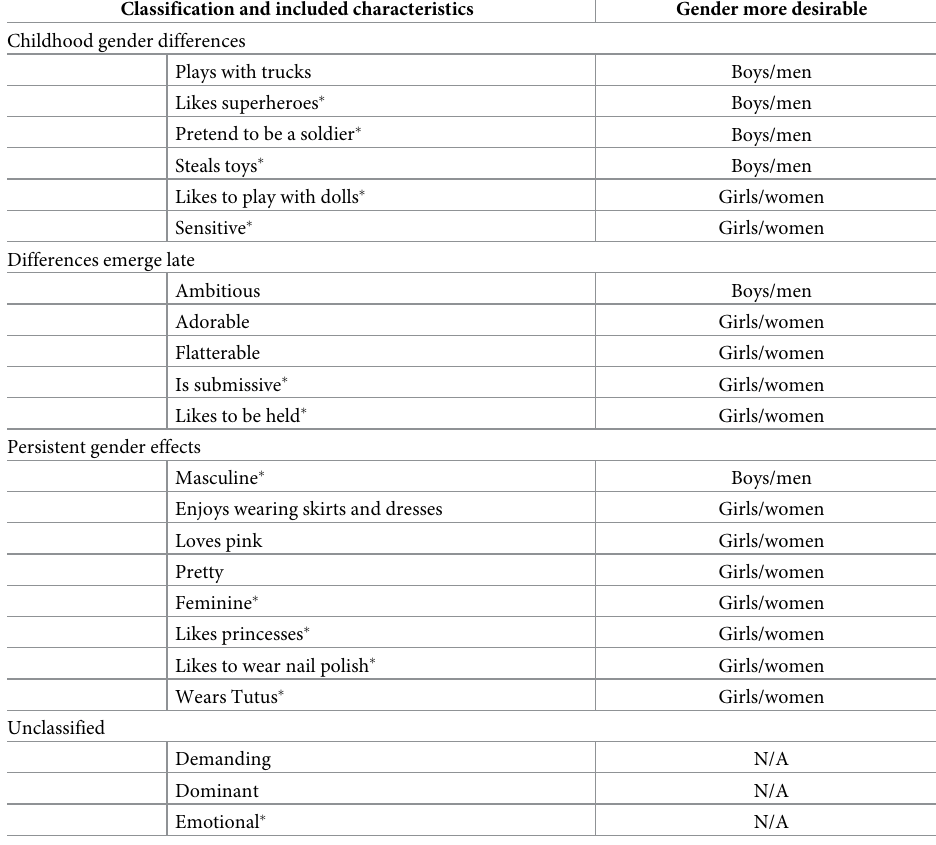
Note . Asterisks indicate that characteristic also had a descriptive interaction (see Table